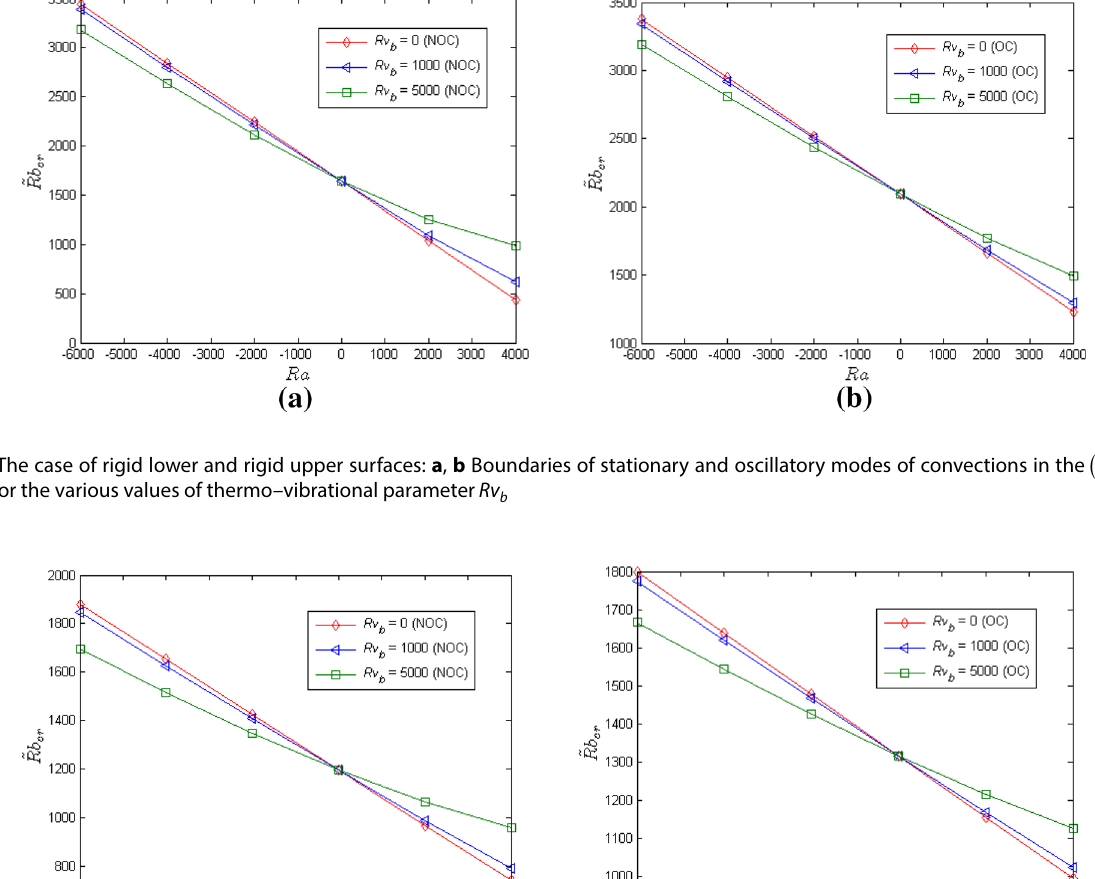
Fig. 6 The case of rigid lower and stress free upper surfaces: a , b Boundaries of stationary and oscillatory convections in the ( Ra , for the varying values of vibrational Rayleigh number Rv